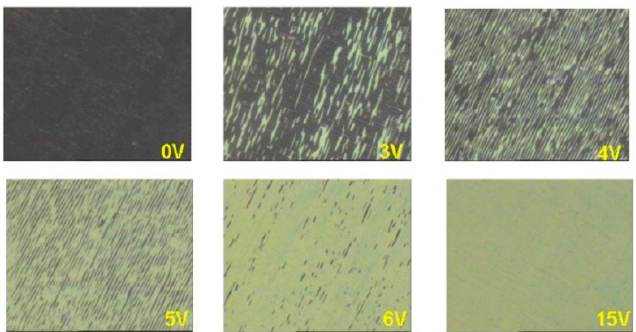
Figure 8. Continuous variation of the width of ferroelectric domains between crossed polarizers with a change in the applied voltage of the FLC layer. The image area is 350 × 400 µ m 2 [34].